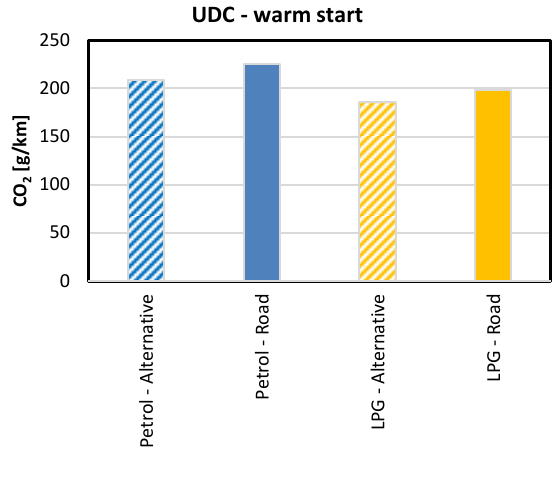
Fig. 4. Impact of resistance forces on CO 2 emissions for UDC